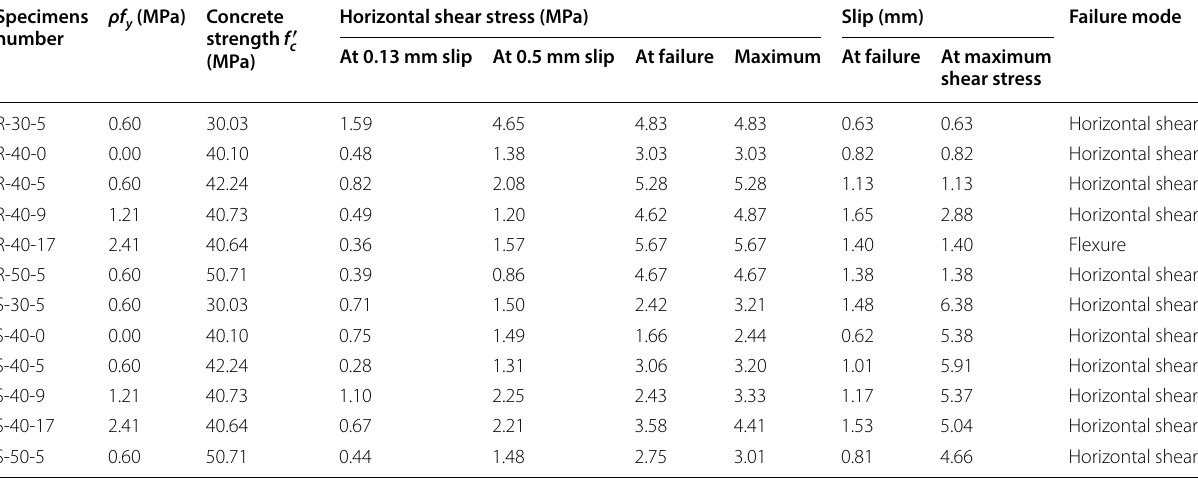
Table 7 Physical properties of test